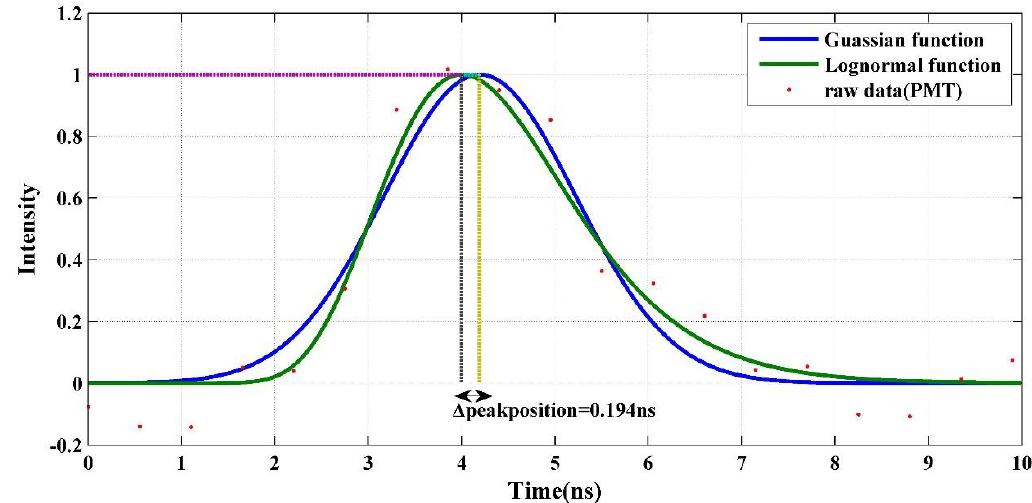
Figure 3. Comparison between Gaussian (continuous line) and lognormal (dotted line) functions.